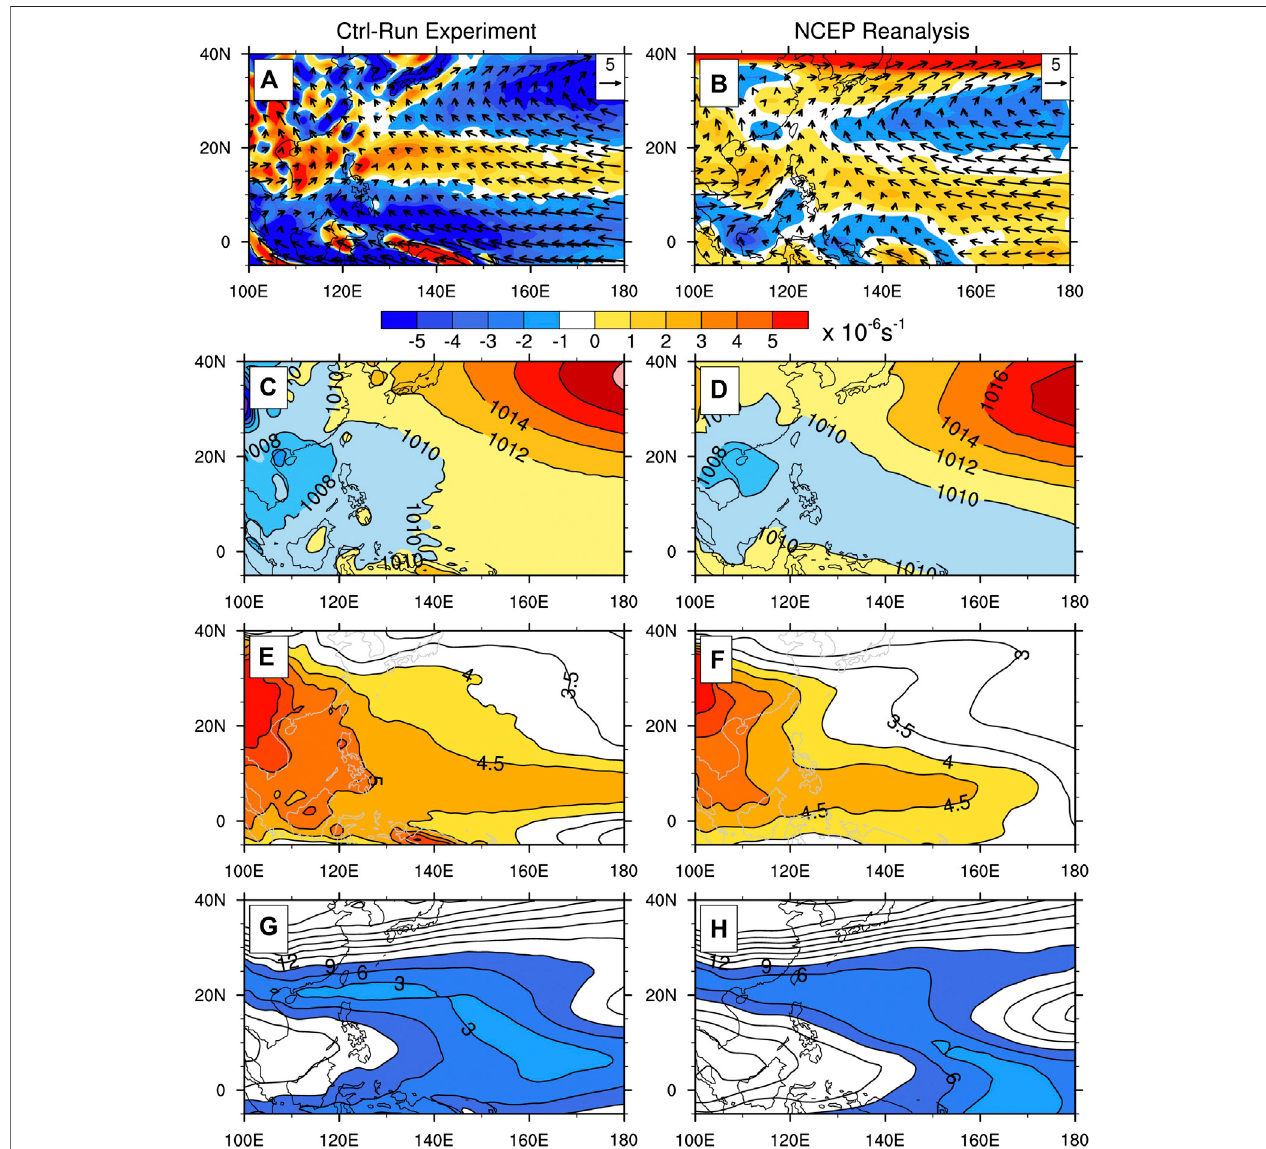
FIGURE 3 | Climate state of the control-run experiment and NCEP reanalysis data during May to October. (A and B) Average wind fi eld (m s − 1 ) and vorticity fi eld (10 − 6 s − 1 ) at 850 hPa. (C and D) Average sea-level pressure (hPa). (E and F) Average speci fi c humidity fi eld (10 − 3 kg kg − 1) at 500 − 700 hPa. (G and H) Average vertical wind shear fi eld between 200 hPa and 850 hPa (m s − 1